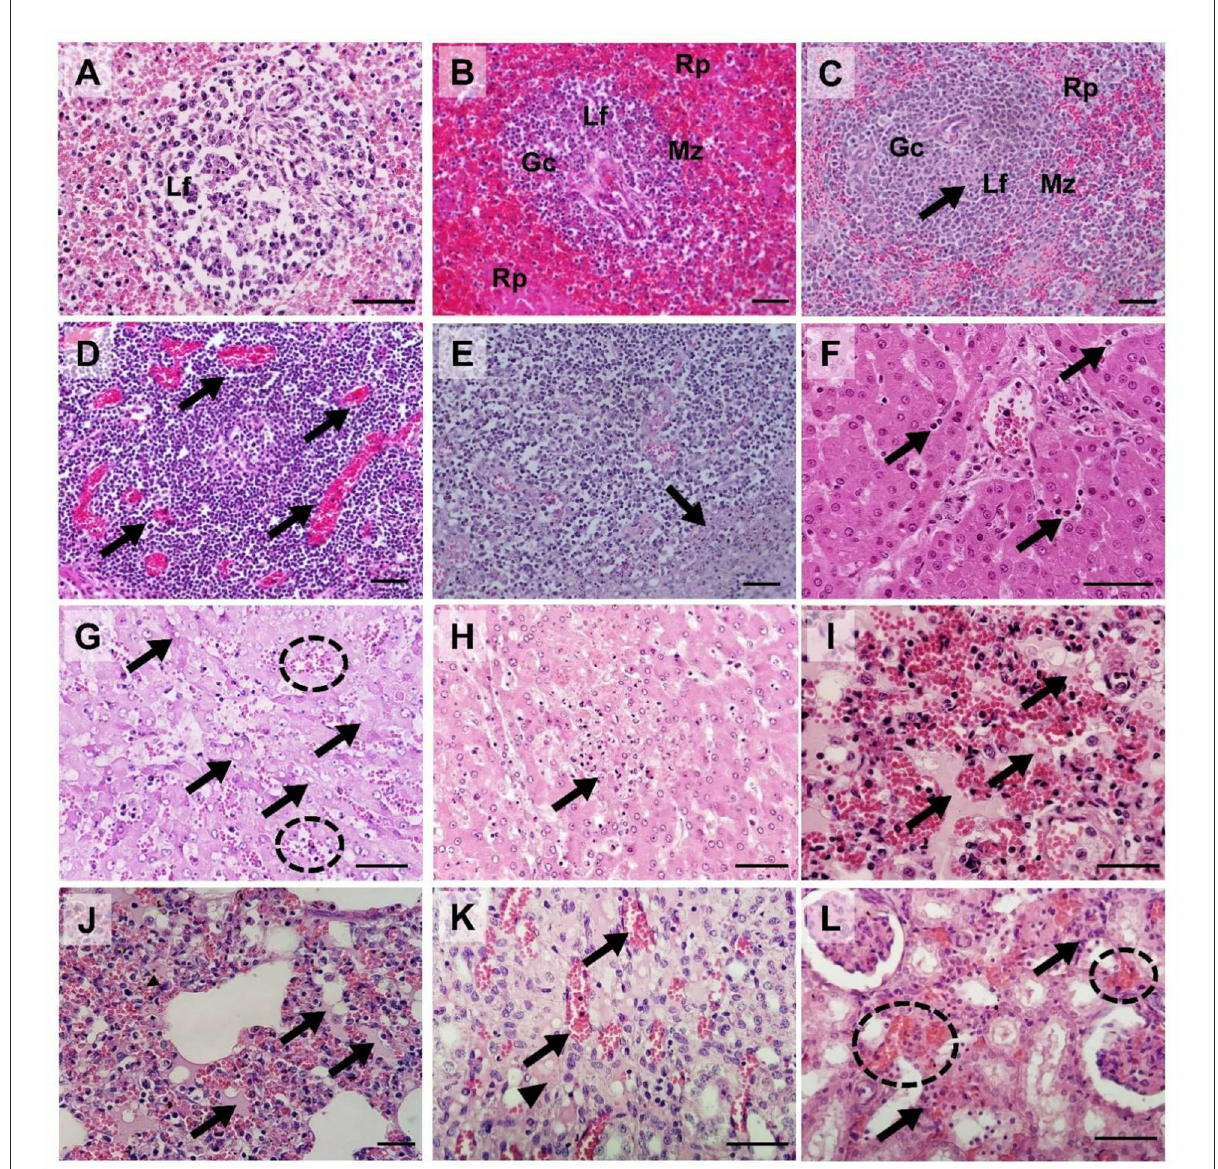
FIGURE6 Histopathological findings in pigs experimentally infected with African swine fever virus. (A) Spleen [pig #54: died at 3 dpv [(Group I)]: Severe lymphoid depletion with the presence of pyknosis and karyorrhexis in the lymphoid follicle (Lf); (B) Spleen [pig #60: died at 6 dpv (Group II)]: Mild lymphocytic depletion in germinal center (Gc), The marginal zone (Mz) infiltrated by erythrocytes, severe and diffuse engorgement in the red pulp (Rp); (C) Spleen [pig #48: died at 4 dpv (Group I)]: Necrosis of lymphocytes (arrow) within the lymphoid follicle (Lf); (D) Submandibular lymph nodes (pig #54): Severe congestion (arrows); (E) Submandibular lymph nodes (pig #60): Focal necrosis (arrow); (F) Liver (pig #54): Neutrophils (arrows) in sinusoids. (G) Liver (pig #60): Multifocal congestions (dash circle) and the cytoplasmic vacuoles (arrows); (H) Liver (pig #43: died at 7 dpv [Group II]): Vacuolar degeneration with necrotic hepatocytes (arrow); (I) Lungs (pig #54): Pulmonary hemorrhages with edema (arrows); (J) Lungs (pig #60): Moderate pulmonary hemorrhages with edema fluids (arrows) and interstitial pneumonia; (K) Kidney (pig #48): Congestion (arrows) and interstitial edema (arrowhead) in the renal medulla.; (L) Kidney (pig #60): Multifocal hemorrhage (dash circles) and mononuclear cell infiltration in the renal interstitium (arrows). Hematoxylin and eosin stain ( × 400 magnification; scale bar, 50 µ m). dpv, days post-viremia; Gc, germinal center; Lf, lymphoid follicle; Mz, marginal zone; Rp, red pulp.